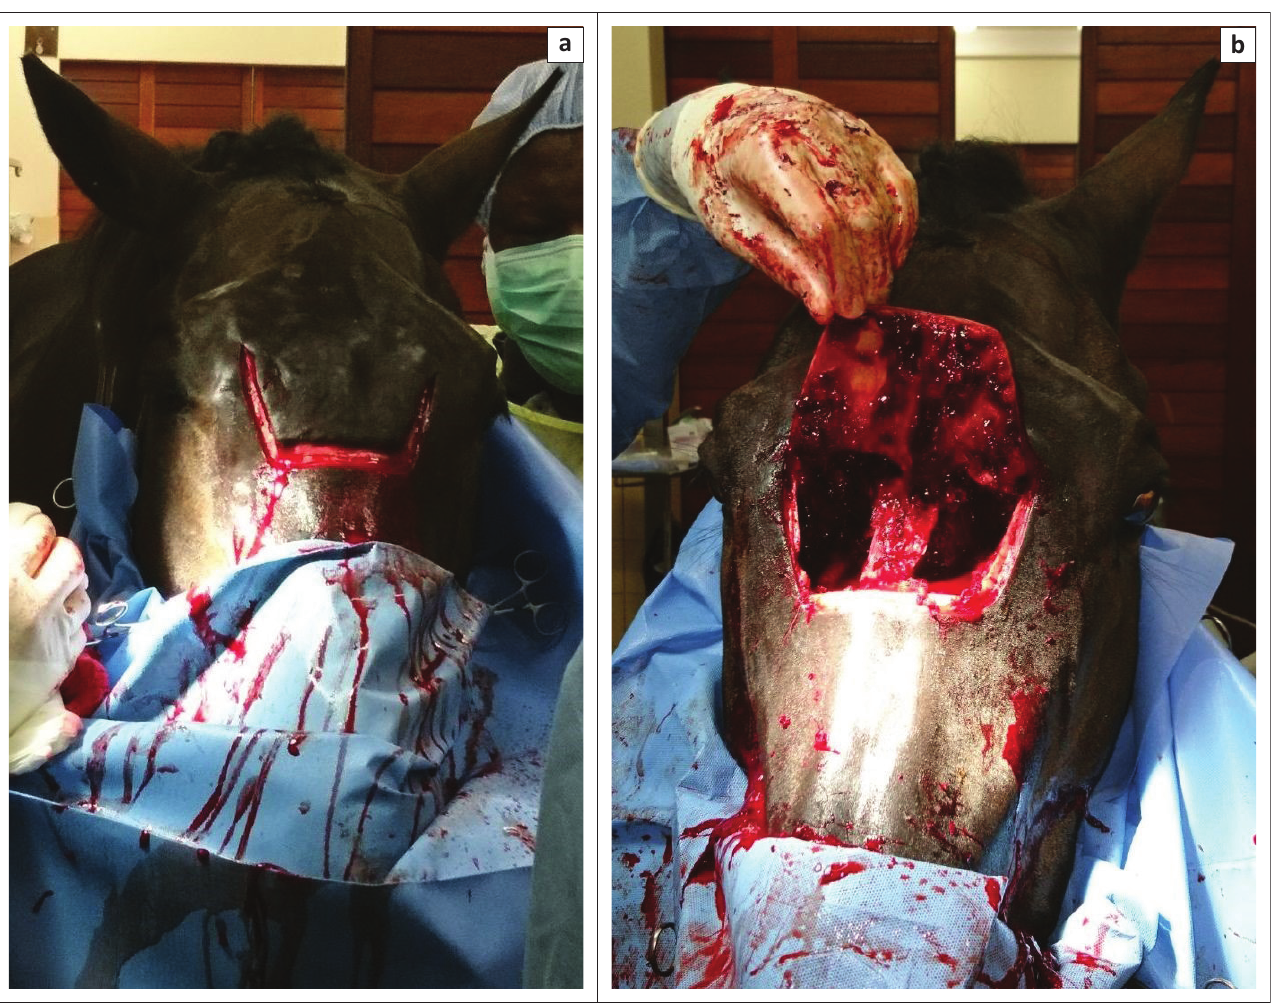
FIGURE 3: Intraoperative photographs during creation of a large bilateral frontonasal bone flap on a standing horse. (a) Skin incision performed according to the described boundaries. (b) Image taken after extirpation of the abnormal sinonasal tissues and before packing. Note the excellent surgical exposure gained through this